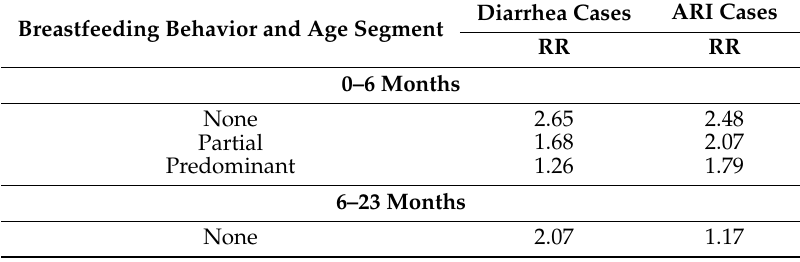
Table 4. Relative risk (RR) of Diarrhea and ARI by Breastfeeding Status